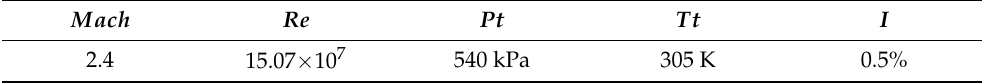
Table 2. Free stream flow parameters: Pt —total Pressure, Tt —total Temperature, I —turbulence